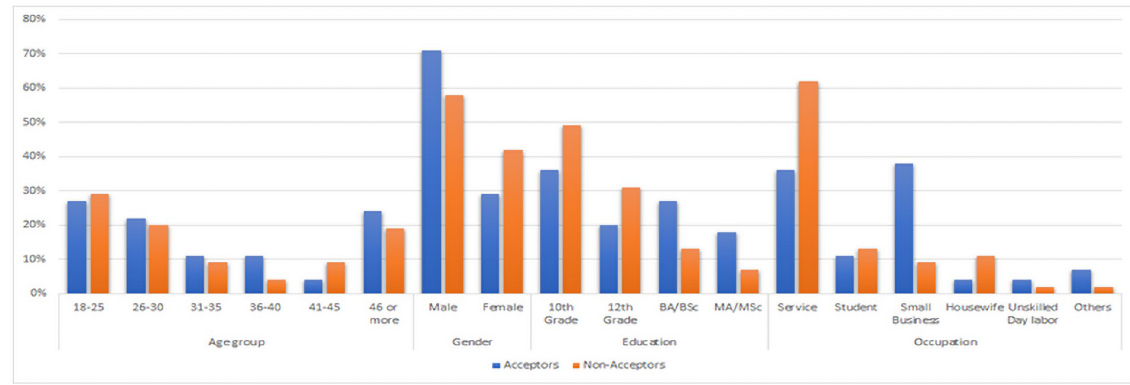
Fig 1. Respondents’ demographic